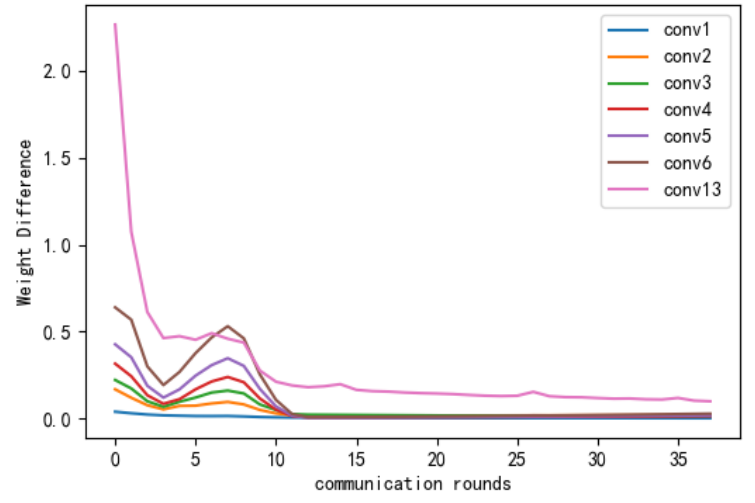
Figure 13. The single-layer weight differences.